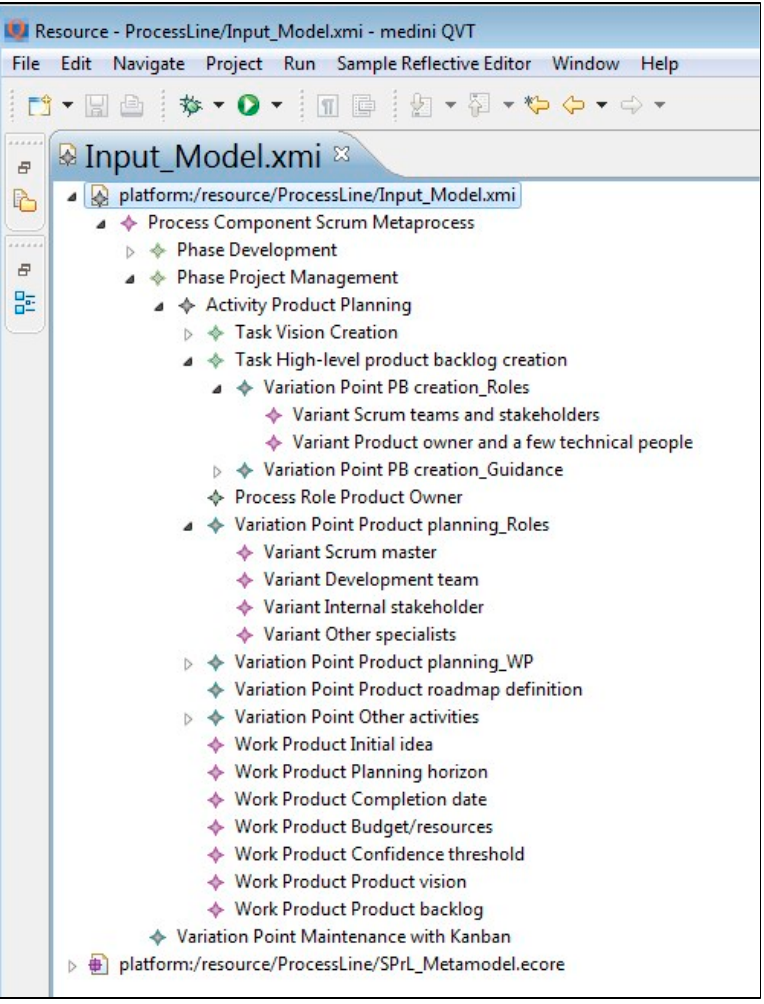
Figure A2. Variabilities modeled via the Medini ‐ QVT tool (signified by the keyword “Variation Point”).